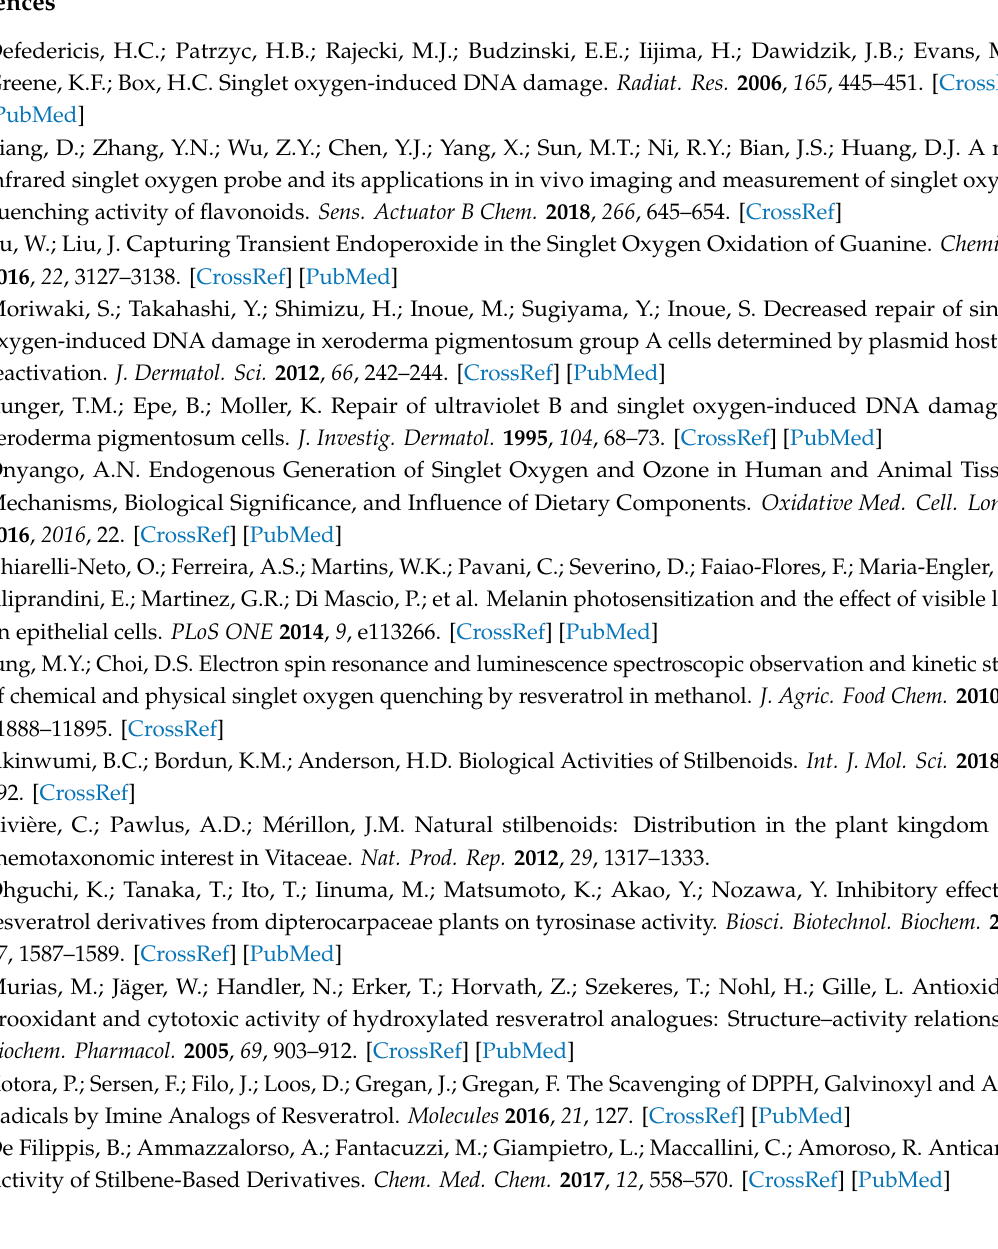
Table S1. The bond length and bong angle of compound 1-1 , 1-2 and parameters of the optimal